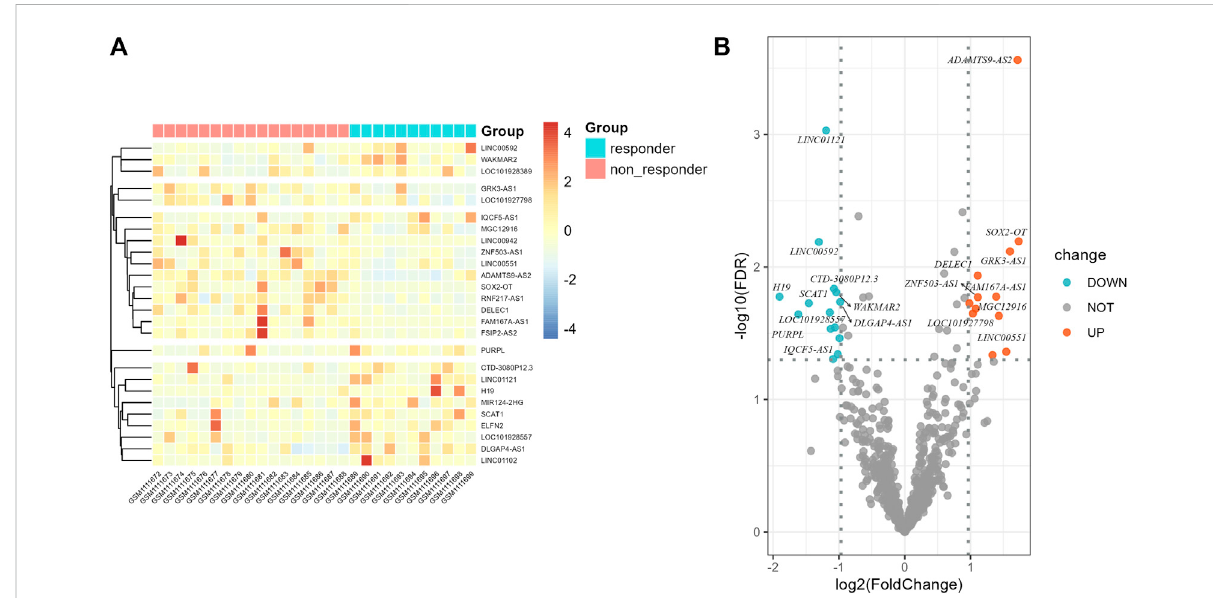
FIGURE 2 Differential expression results of immune-related lncRNAs in GSE45670 cohort. (A) Heatmap, (B) Volcano map.